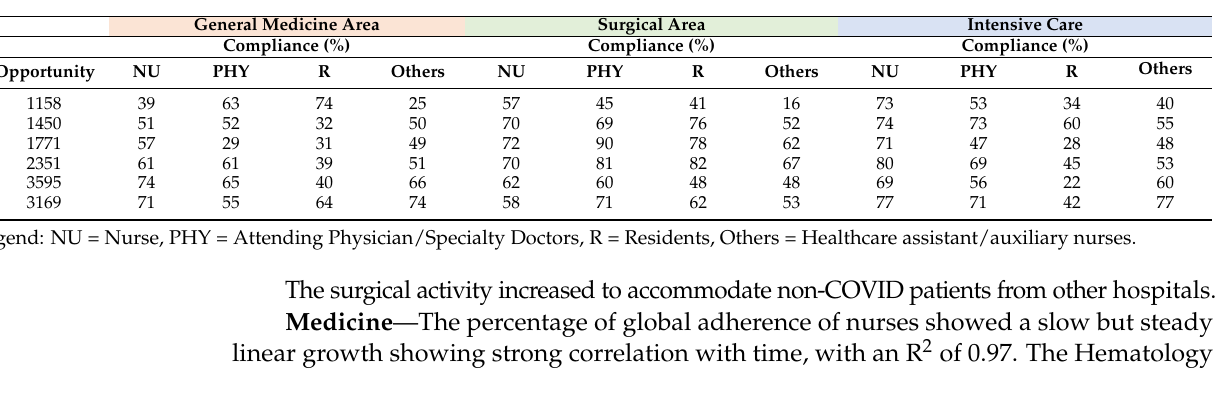
Table 4. Adherence to hand hygiene per areas, per professional category, per